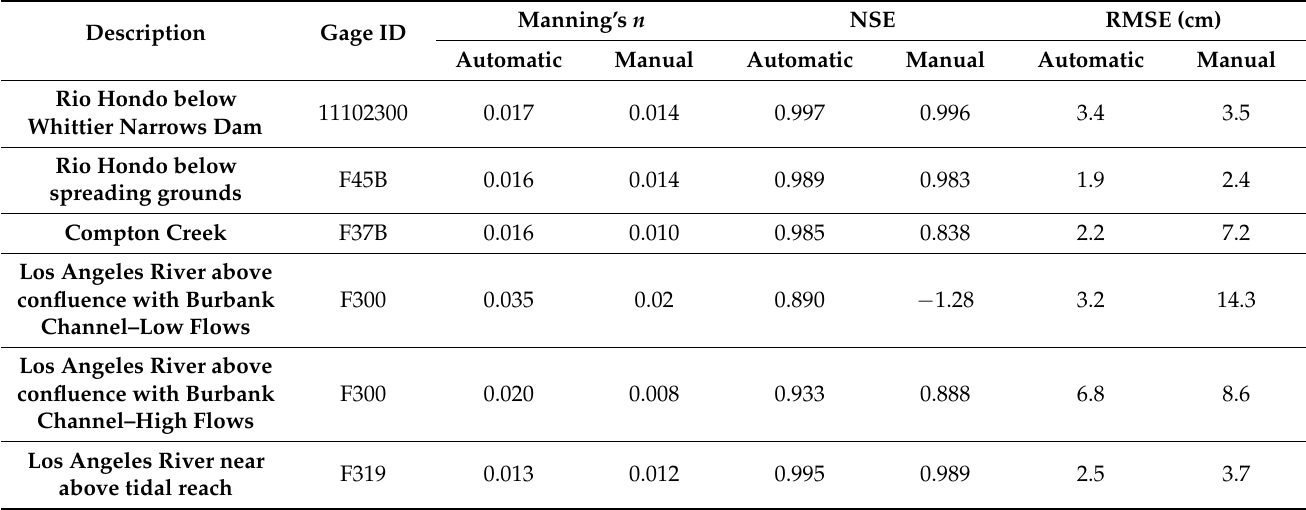
Table 2. Comparison of automatic and manual calibration results for all calibration